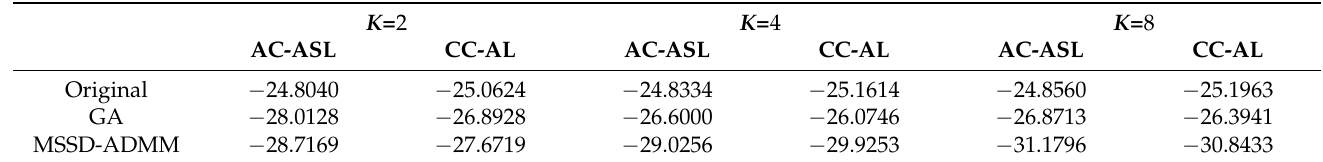
Figure 4. Diagram of AF and CAF before and after optimization. Table 6. AC-ASL and CC-AL metric of LFM-PC